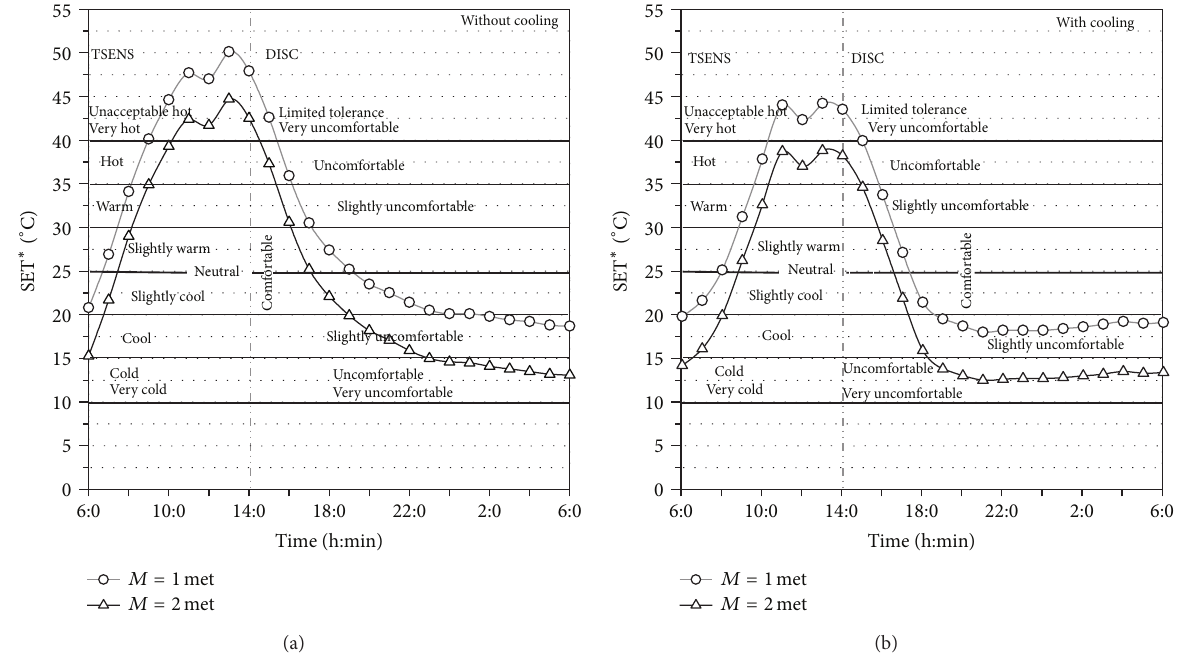
Figure 6: Time course of the standard effective temperature (SET ∗ ) estimated in the greenhouse: (a) without cooling and (b) with cooling of the inside air.